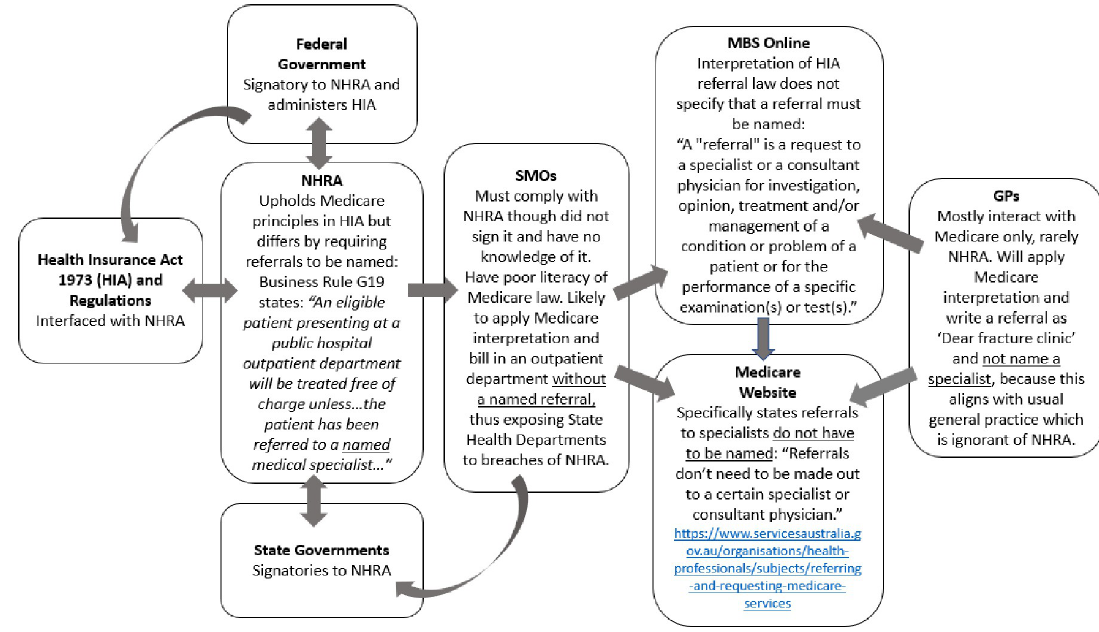
Fig 1. Referral law inconsistencies between Medicare and NHRA and potential